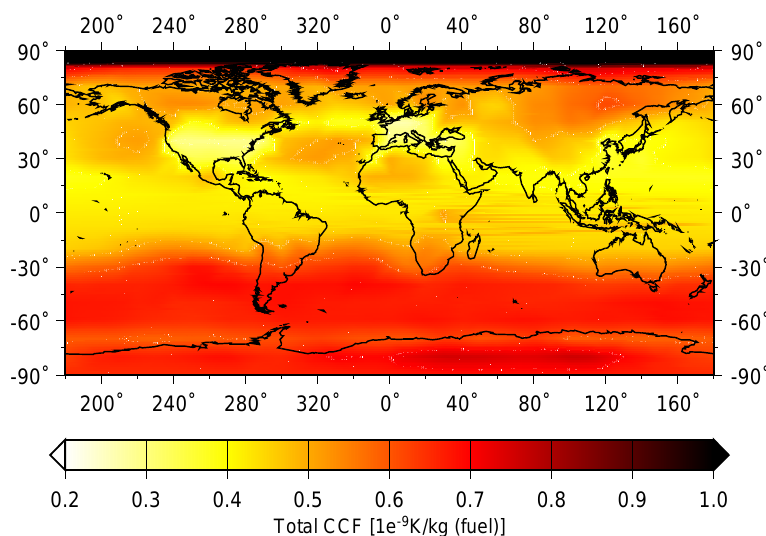
Figure 1. Climatological (annual mean) ECFs (environmental change function) for climate impact of total aviation emission as ATR 100 per kg fuel on FL 310. Following aircraft specific emission indices were used: EI H =1.25 kg/kg, EI NO =17.8 g/kg,0.15 2 O x